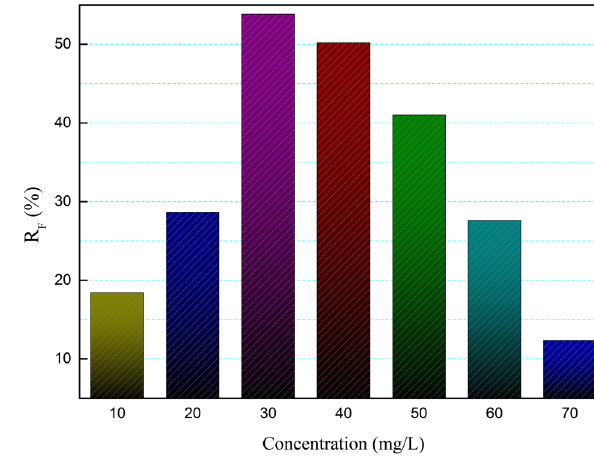
Figure 4: FT - IR spectra of La ( III ) – Al ( III ) – CAC.